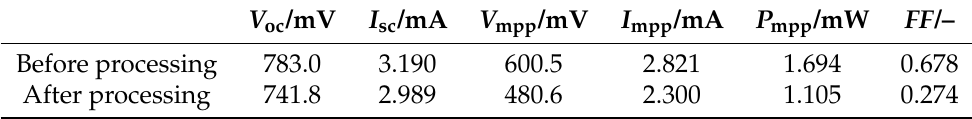
Table 2. The data below show a significant decrease in power after heating to 350°C for 240min. Selected parameters are open-circuit voltage V oc , short-circuit current I sc , voltage at MPP V mpp , current at MPP I mpp , power at MPP P mpp , and fill factor FF .